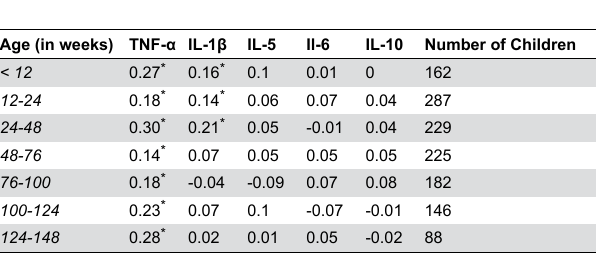
Table 4. Correlation between birth levels and early childhood levels of cytokines.